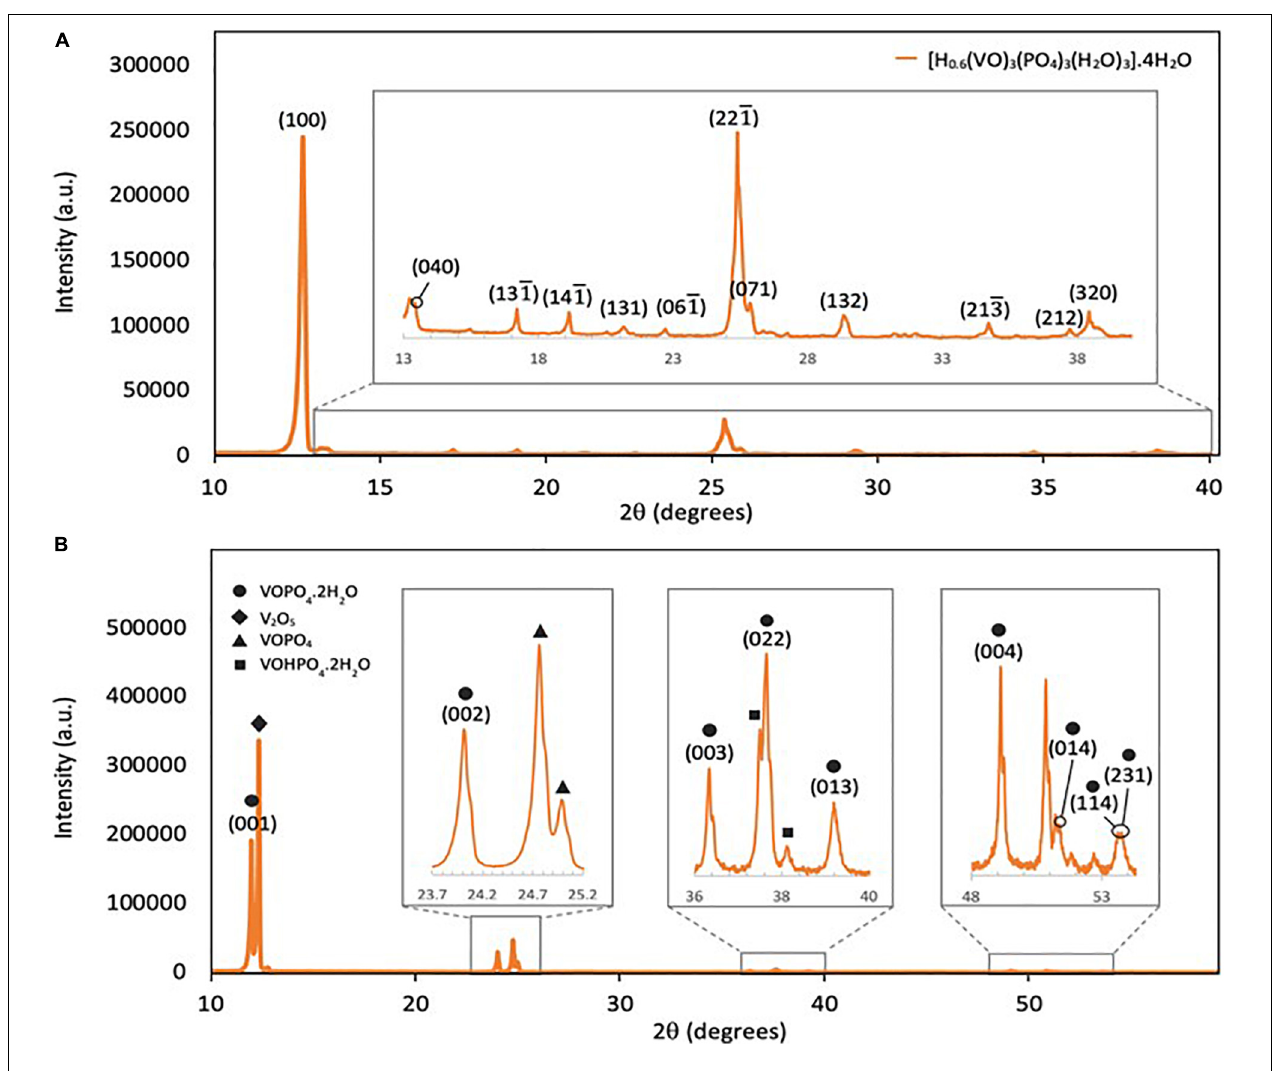
FIGURE 1 | XRD spectra of (A) VOP1 and (B) VOP2.